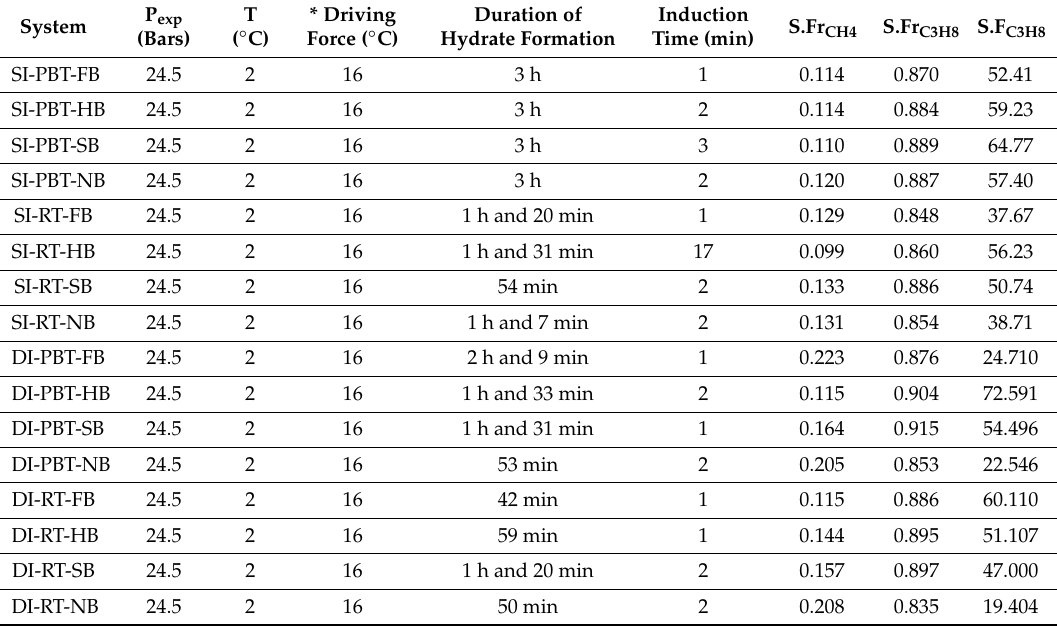
Table 2. Summary of results of single and dual impeller, methane–propane mixture